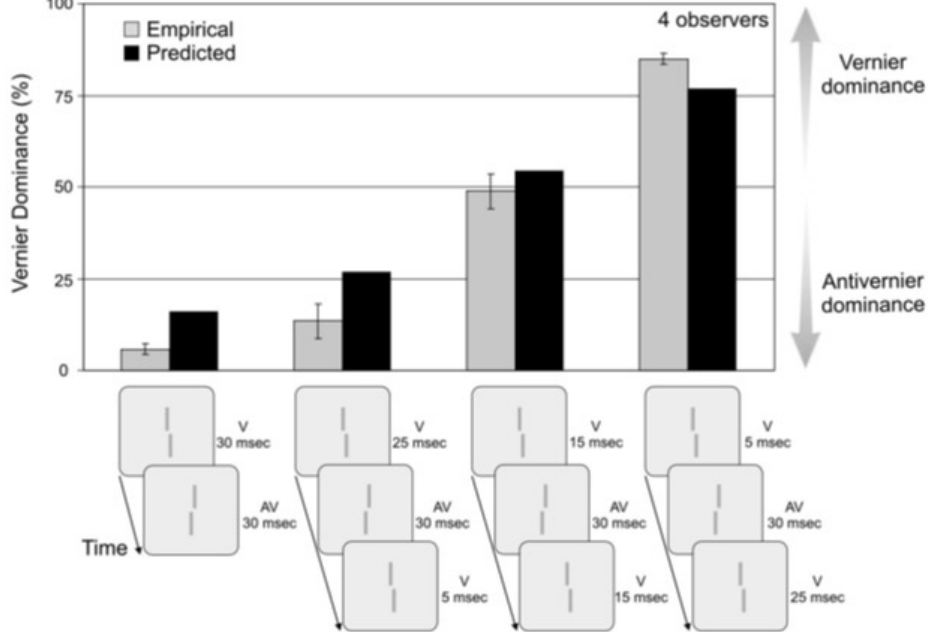
Figure 9. A vernier (V) was followed by a vernier offset in the opposite direction at the location (AV). When the stimulus duration is 30 ms each, the AV strongly dominates. The vernier offset V was presented before and after the AV. We kept the overall duration of the V constant at 30 ms. The longer the after-AV duration, the stronger dominance, i.e., the V contributes more to performance than the AV. Black bars show the predictions of a leaky integrator model. Reprinted with permission from ref. [12]. Copyright 2021 MIT